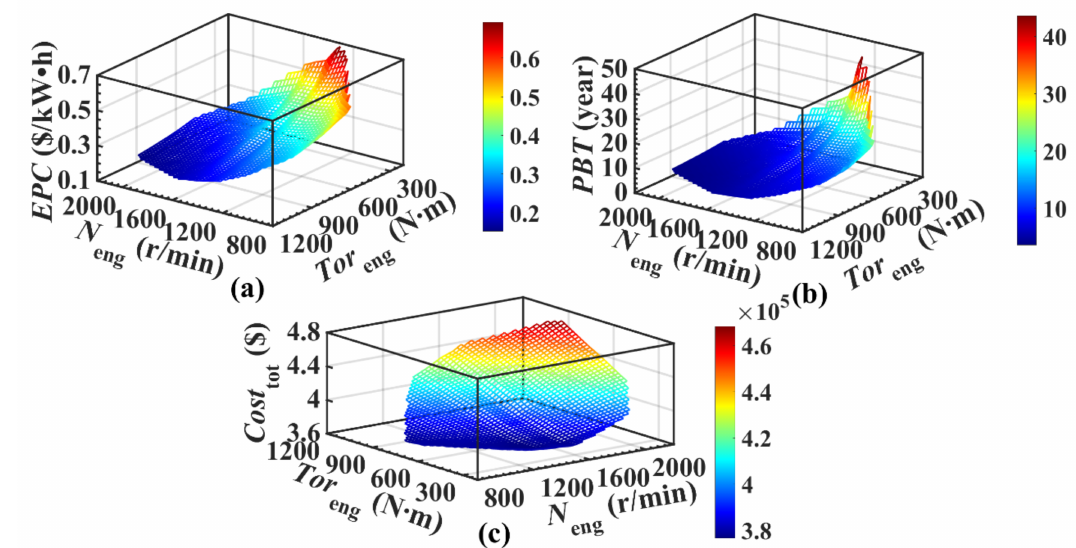
Figure 14. Dynamic response characteristics of system economic performance under full operating conditions. ( a ) EPC dynamic response characteristics of the DORC system. ( b ) PBT dynamic response characteristics of the DORC system. ( c ) dynamic response characteristics of the total investment cost of the DORC